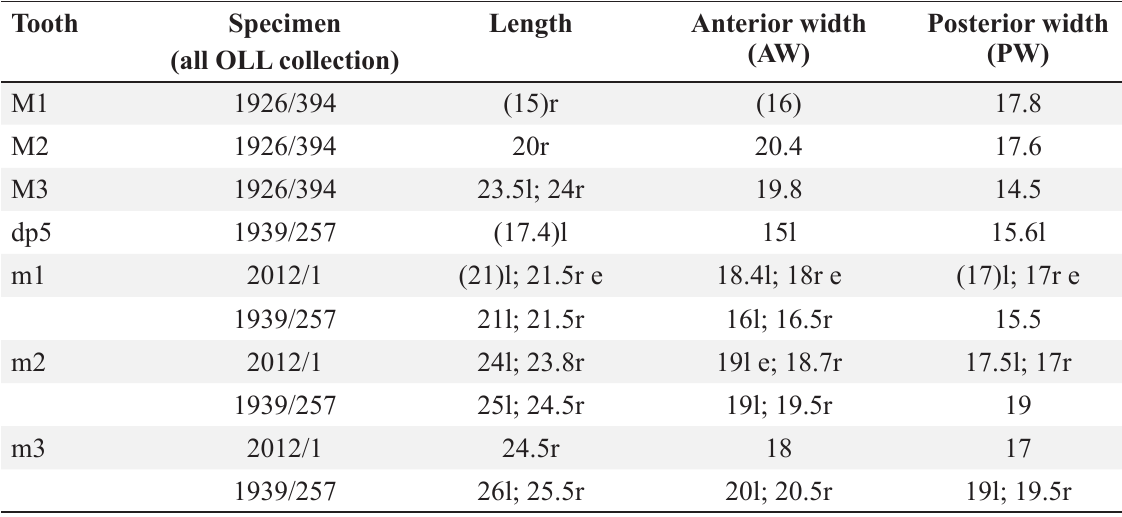
Table 4. Linear dimensions (in mm) of cheek teeth of Lentiarenium cristolii (Fitzinger, 1842). Letters in parentheses denote the preserved lengths, “e” estimated dimensions, “l” and “r” measurements from the left and/or right